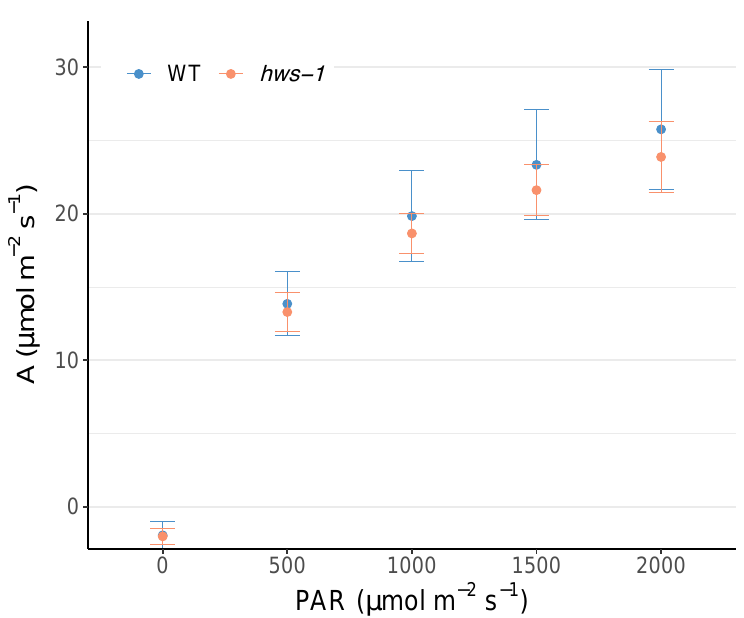
Figure 4. Light-response curves show comparable photosynthetic assimilation between WT and mutant lines. Photosynthetic assimilation was measured on the fourth leaves of 1-month-old plants. Error bars represent standard deviation. Unpaired t -tests indicate that difference are not significant at the p < 0.05 level ( n =